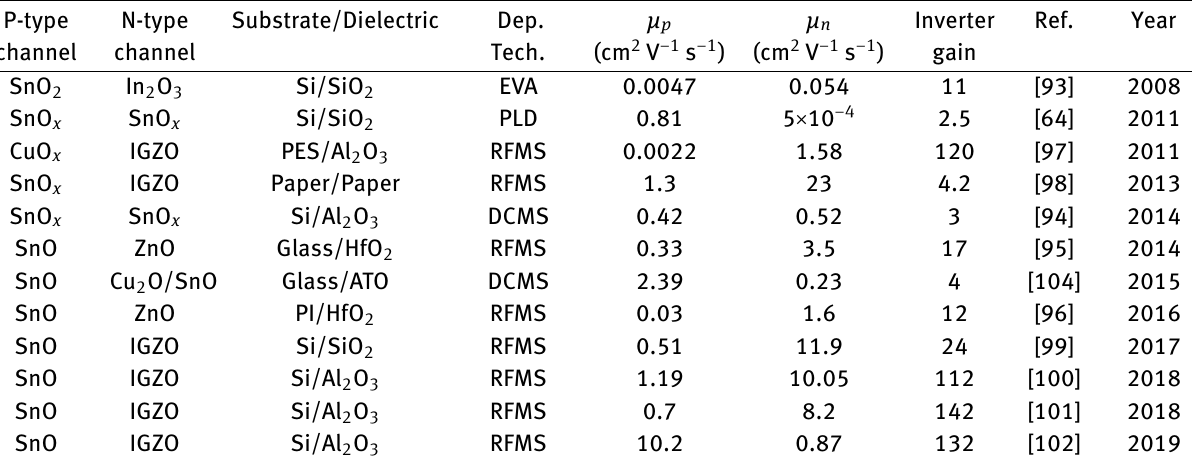
Table 4: Short-review of the reported oxide CMOS inverters P-type N-type Dep. channel